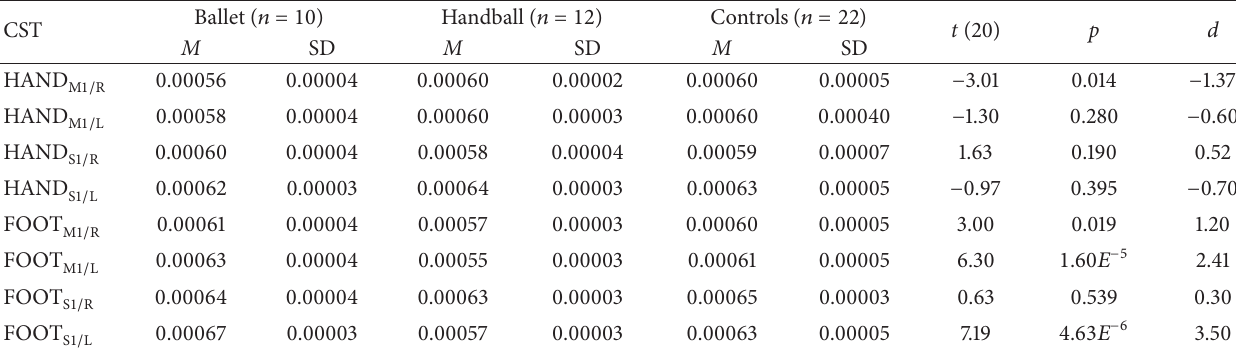
Table 5: Group comparisons of radial diffusivity (RD) in the respective corticospinal tracts